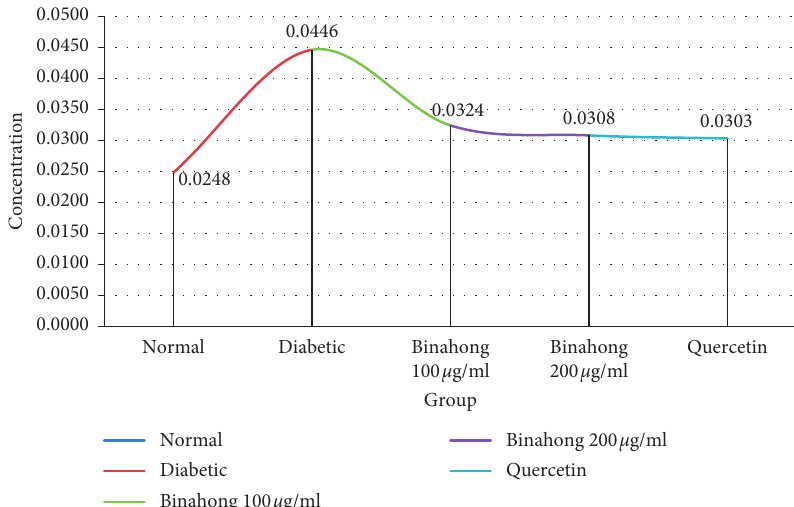
Figure 3: Effects of Binahong leaf extract on MDA level in the lens homogenate after 72 hours of